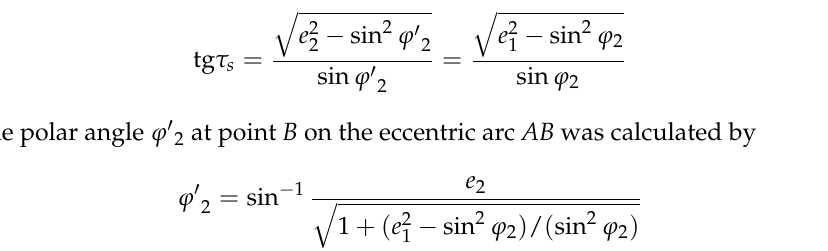
Figure 4. Double-eccentric circle curve, where O 1 and O 2 are the centers of the eccentric circle; φ 0 and φ ’ 2 are polar angles of points A and B on curve AB ; φ 1 and φ 2 are polar angles of points C and B on curve BC ; r 0 , r 1, and r 2 are polar radii of point A , C, and B ; R 1 and R 2 are the radii of the eccentric circle; ρ 1 is the distance between O and O 1 ; ρ 2 is the distance between O and O 2 . The double-eccentric circular-edge design should ensure a smooth transition at the connection of the two arcs. Point B is the intersection point of the two arcs, in which the sliding–cutting angle of the two arcs should be equal: